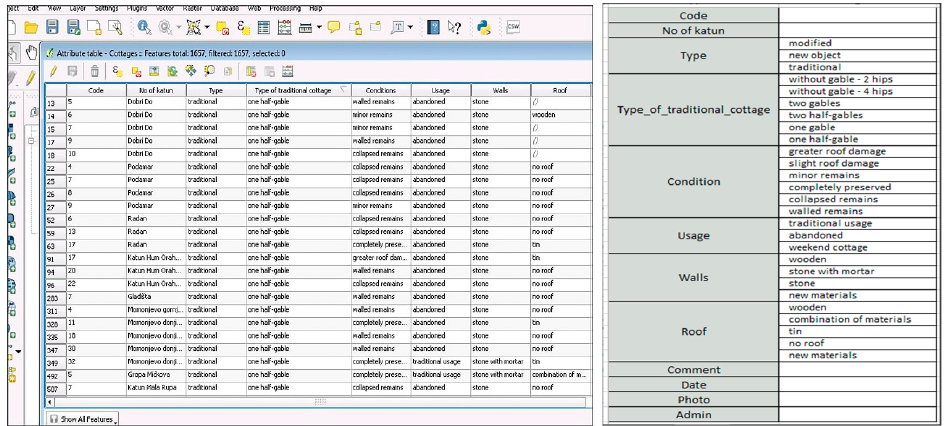
Figure 4. Overview of katun’s attribute table in database and parameters for glada file, entry by O. Pelcer-Vuja č i ć .